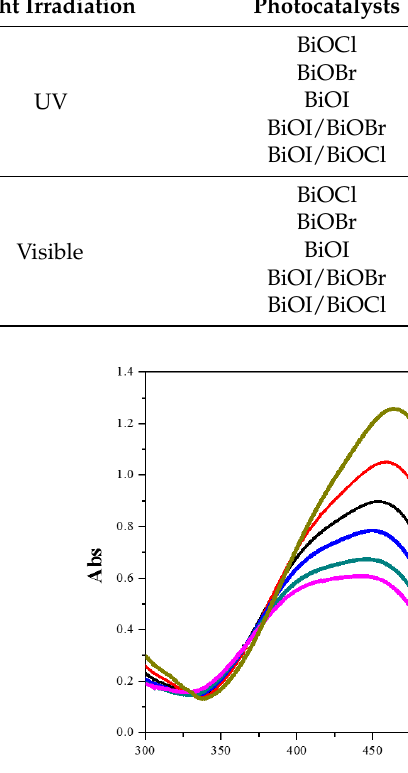
Figure 11. The photocatalytic O 2 evolution of BiOI, BiOCl, and BiOI/BiOCl composites. 3.5.3. Photocatalytic Mechanism of the BiOI/BiOCl Composite